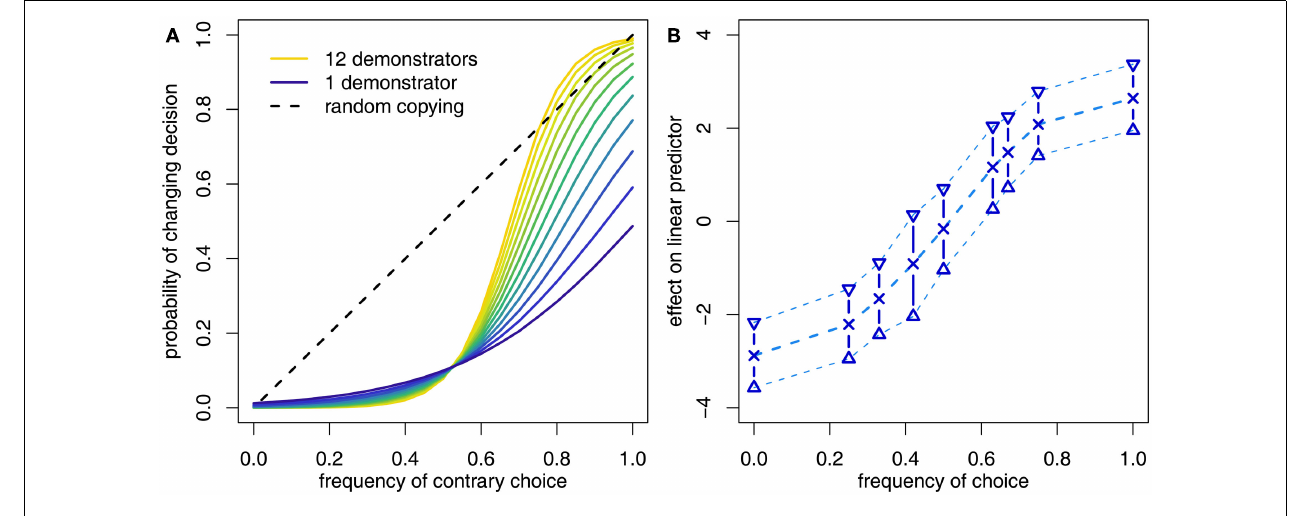
asocial information showed that the response of subjects to the social information in isolation was more generally conformist, as illustrated by the S-shaped curve. In this case the y -axis reflects the change to a linear predictor prior to transformation into a probability and the shape of the curve was not constrained in any